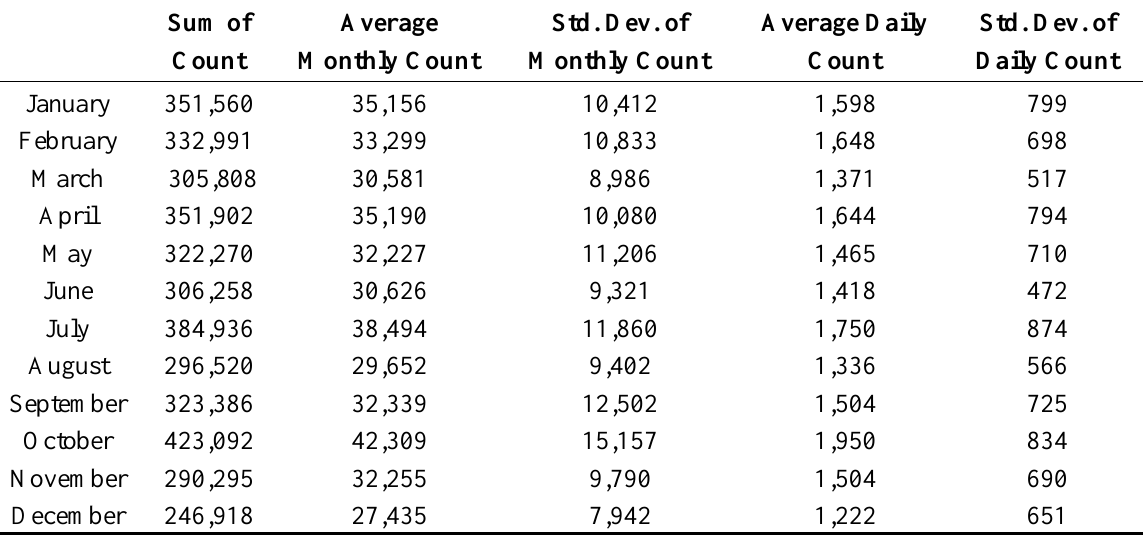
Table 1. News counts by month from 1 January 2003–31 October 2012. For every month during January 2001–October 2012, we count the number of news stories by binning the timestamps into the monthly bins, and we aggregate the counts by months of the year (Std. Dev. = standard